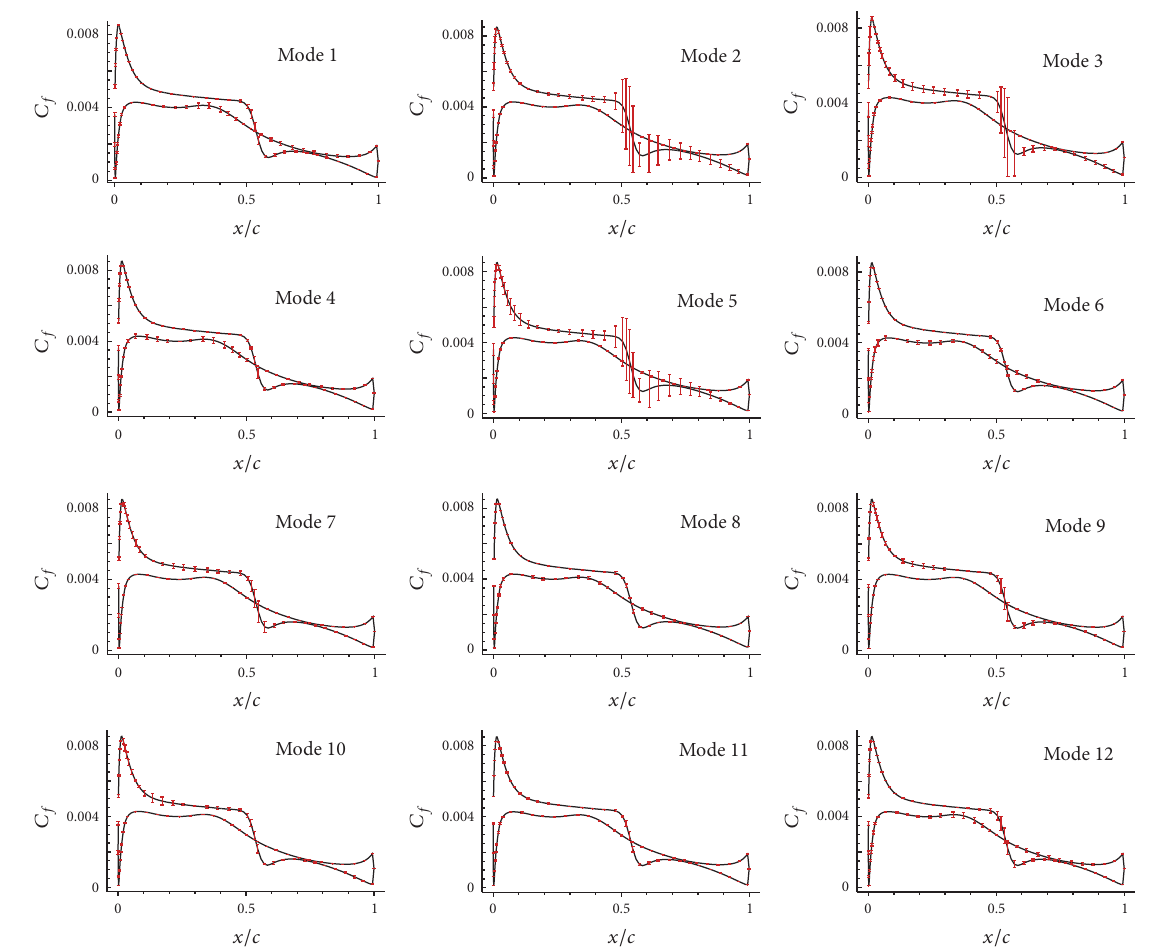
Figure 15: The error bars of 𝐶 𝑓 distribution by Sobol’s